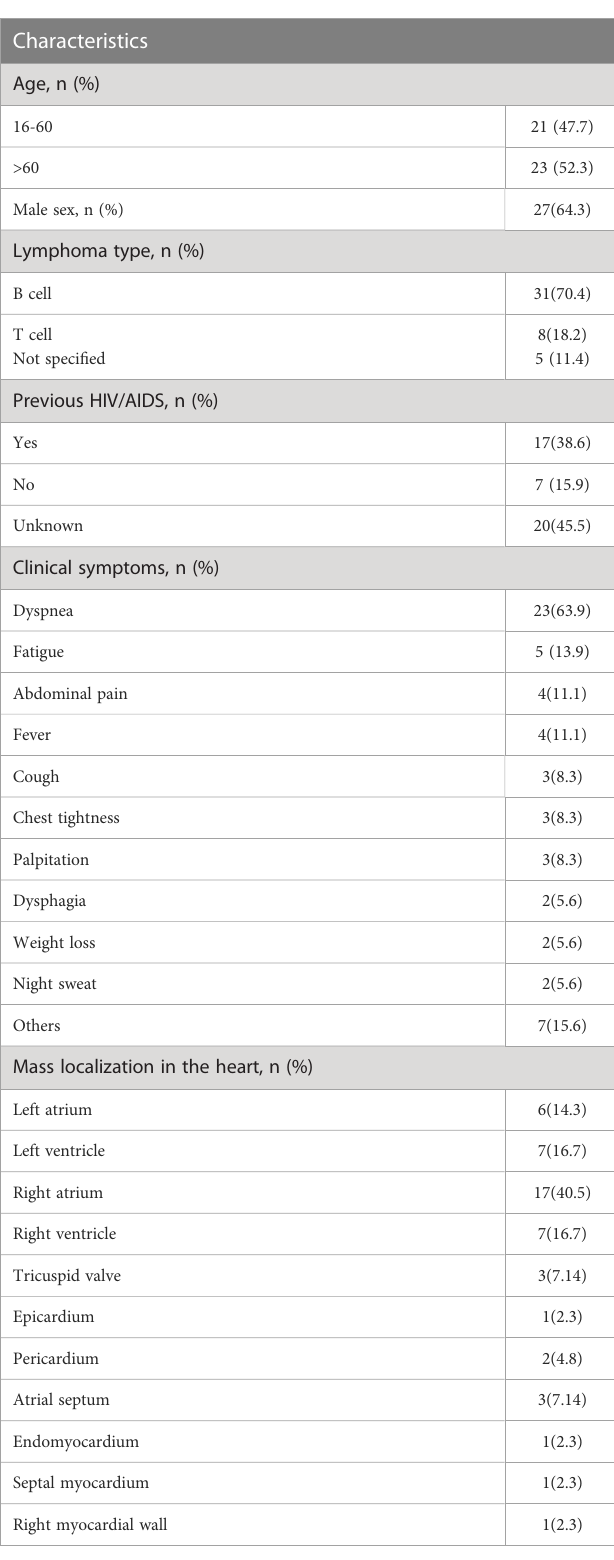
TABLE 1 Clinical characteristics of patients with cardiac lymphoma reported to date (10 –